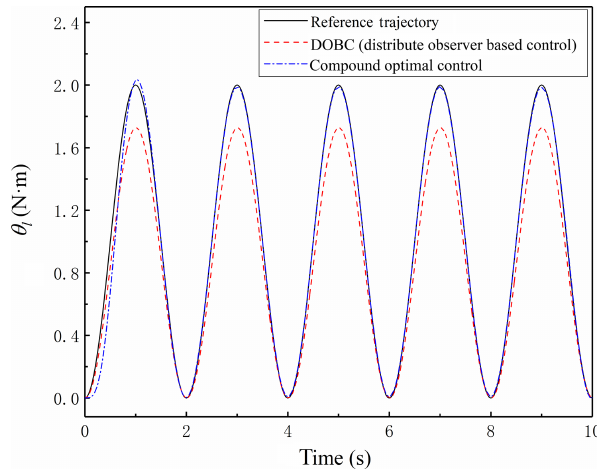
Figure 5. The cosine wave tracking effect of the compound optimal control and DOBC. The tracking curve of the compound optimal control almost overlaps with the reference